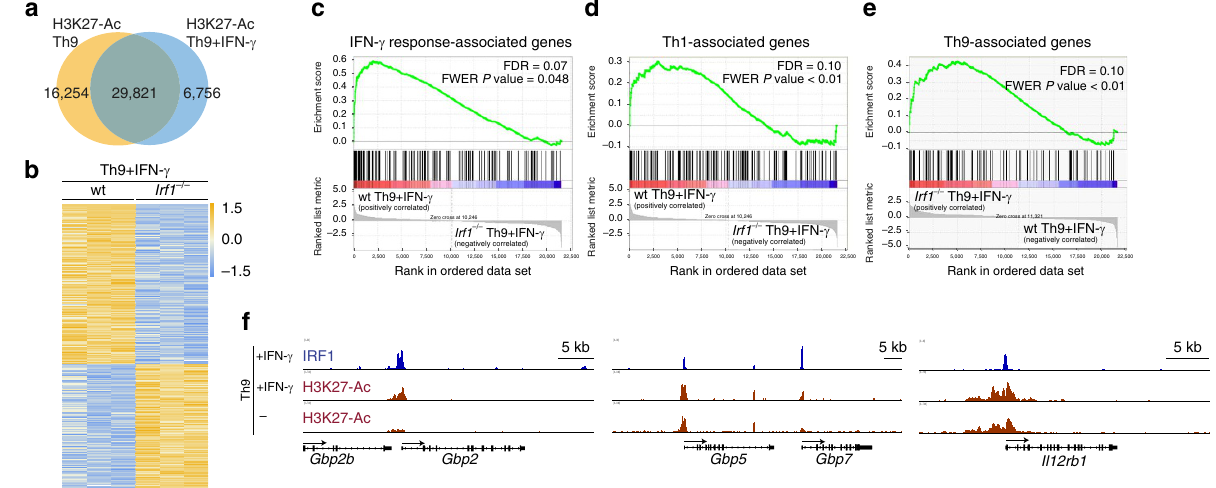
Figure 4 | The IFN- c /IRF1 pathway upregulates IFN/Th1-associated genes in Th9 cells. ( a ) ChIP-Seq analyses of Th9 cells with or without IFN- g treatment. Cells were crosslinked with formaldehyde and immunoprecipitated with anti-H3K27-Ac antibodies. Massive parallel sequencing of immunoprecipitated DNA was performed. Numbers in the Venn diagram represent H3K27-Ac peaks. ( b ) Naive CD4 þ T cells isolated from WT and Irf1 (cid:2) / (cid:2) mice were cultured under Th9 conditions in the presence of IFN- g . Total RNA was purified from the cells and RNA-Seq was performed